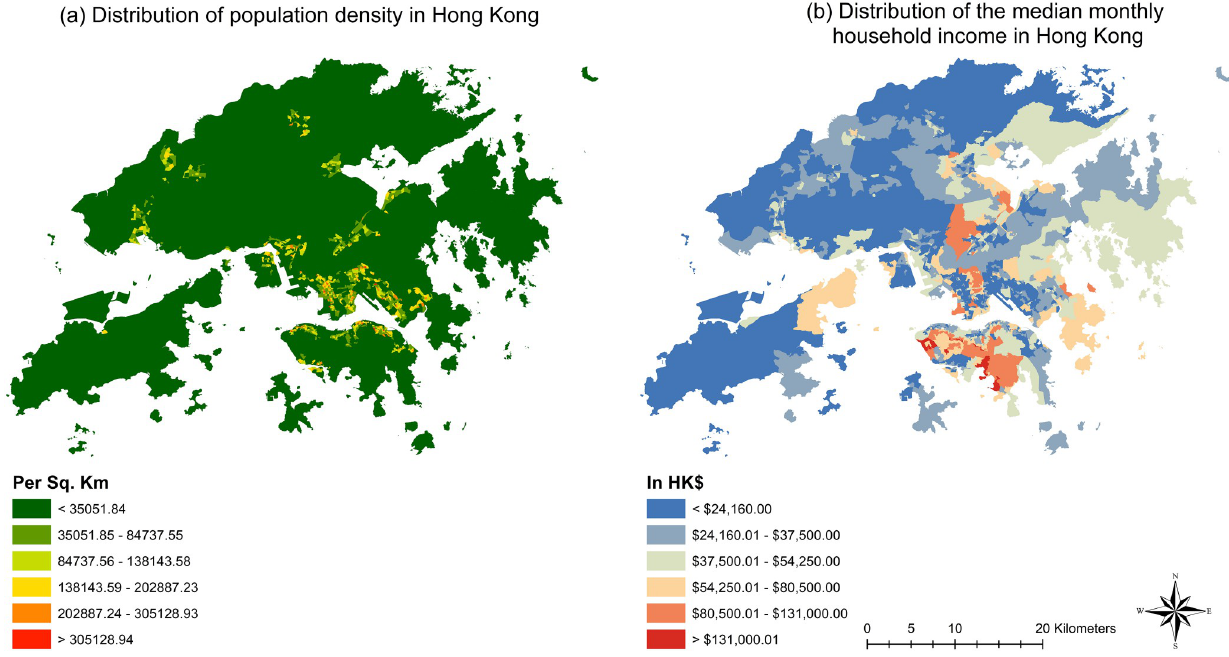
Fig 2. Distribution of (a) population density; (b) median monthly household income in Hong Kong.